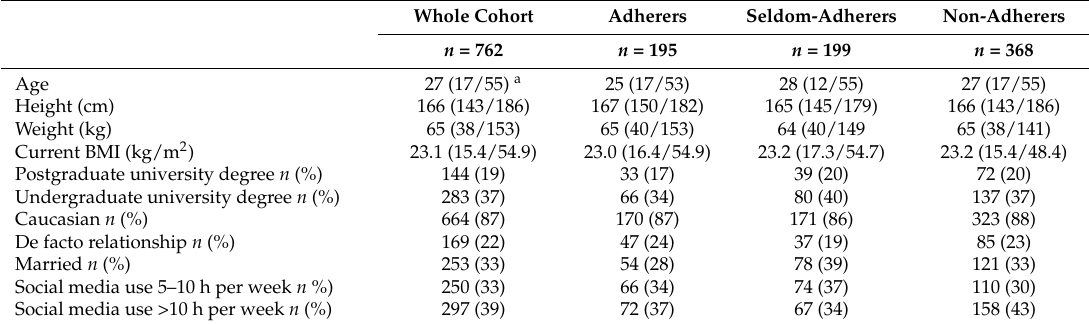
Table 1. Participant characteristics stratified by self-reported adherence to dietary advice from clean eating sites.